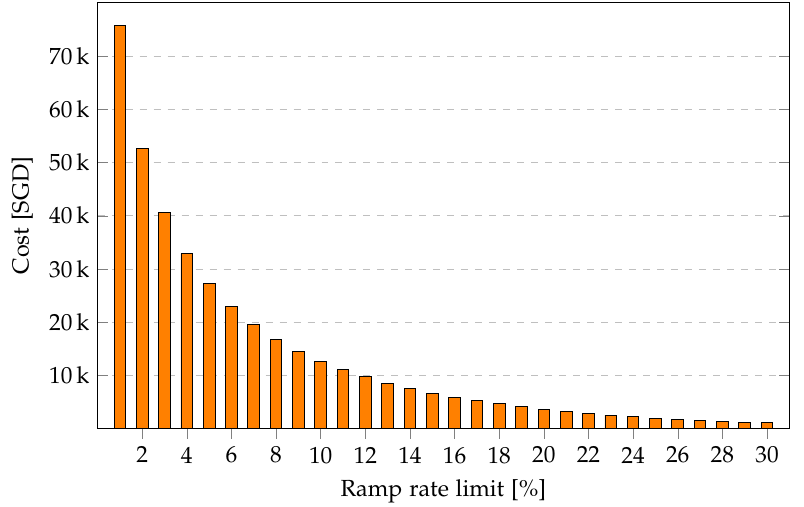
Figure 4. PV ramped cost (SGD) over PV ramp rate limit for one